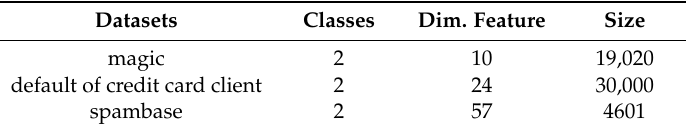
Table 1. Datasets from UCI repository.